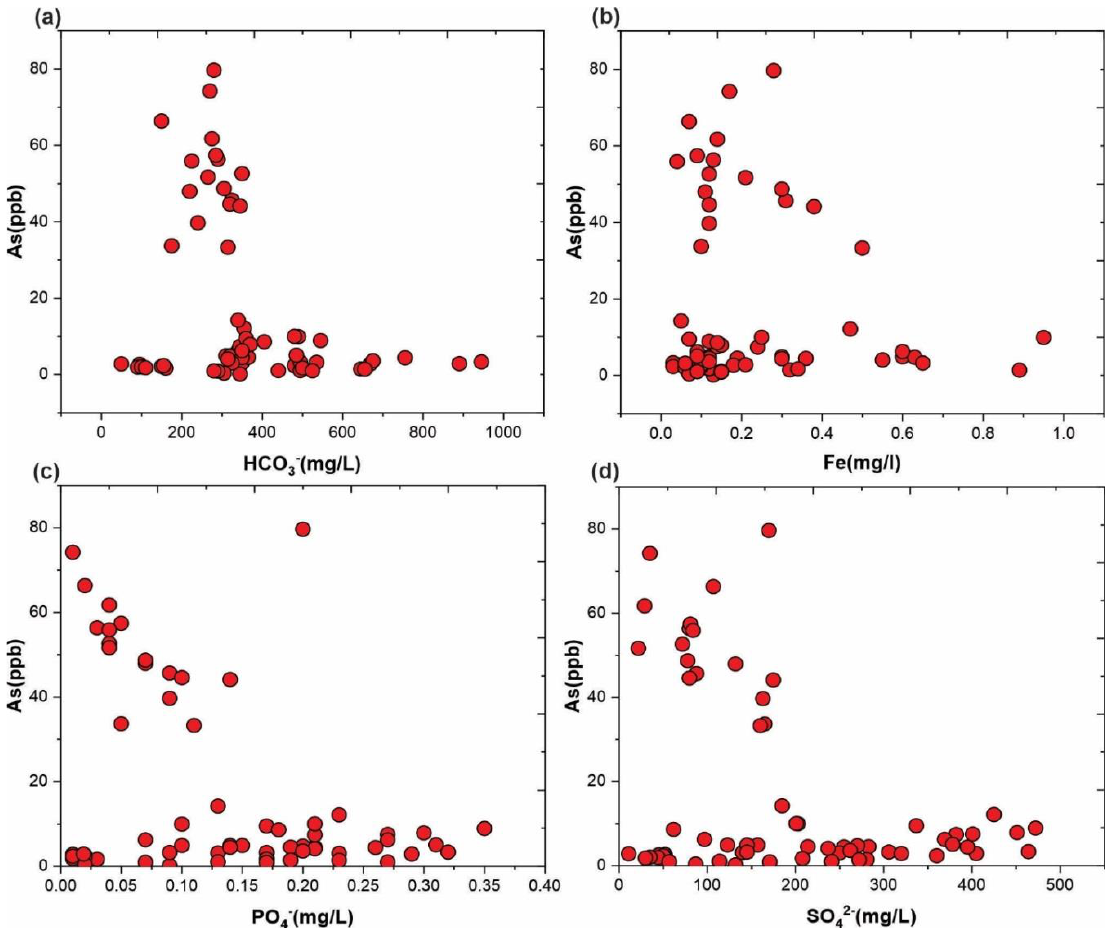
Figure 3. Scatter plot, Na/Cl vs. EC ( a ), scatter plot of As vs. PH ( b ), and NO 3 − vs. As plot ( c ).